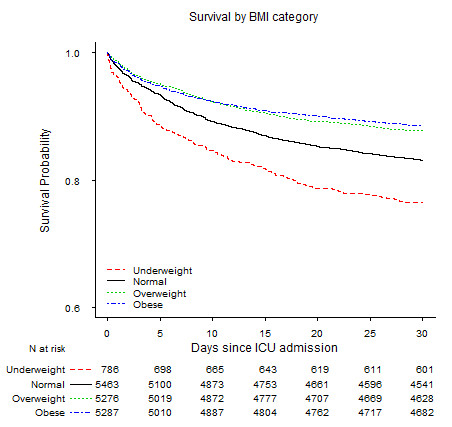
Kaplan-Meier curve for 30-day survival by BMI category. Kaplan-Meier curve for survival by BMI category over the first 30-day period. The numbers represent the number of patients still surviving in each BMI category at the start of each time period. Note: the survival probability is truncated at 0.6 for display purposes.